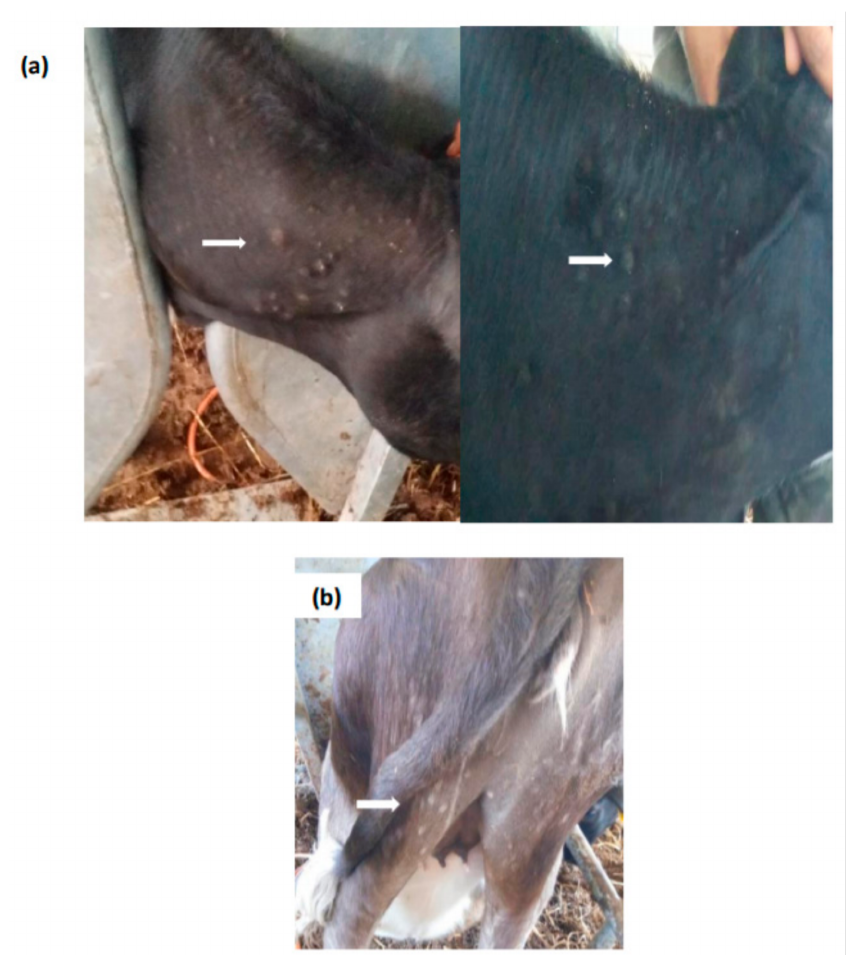
Figure 4. ( a ) Localized skin lesions in the neck seen in cattle vaccinated with Neethling strain (G2). ( b ) Localized skin lesions in thighs regions and perineum seen in cattle vaccinated with Kenya strain (G4). Arrows show skin